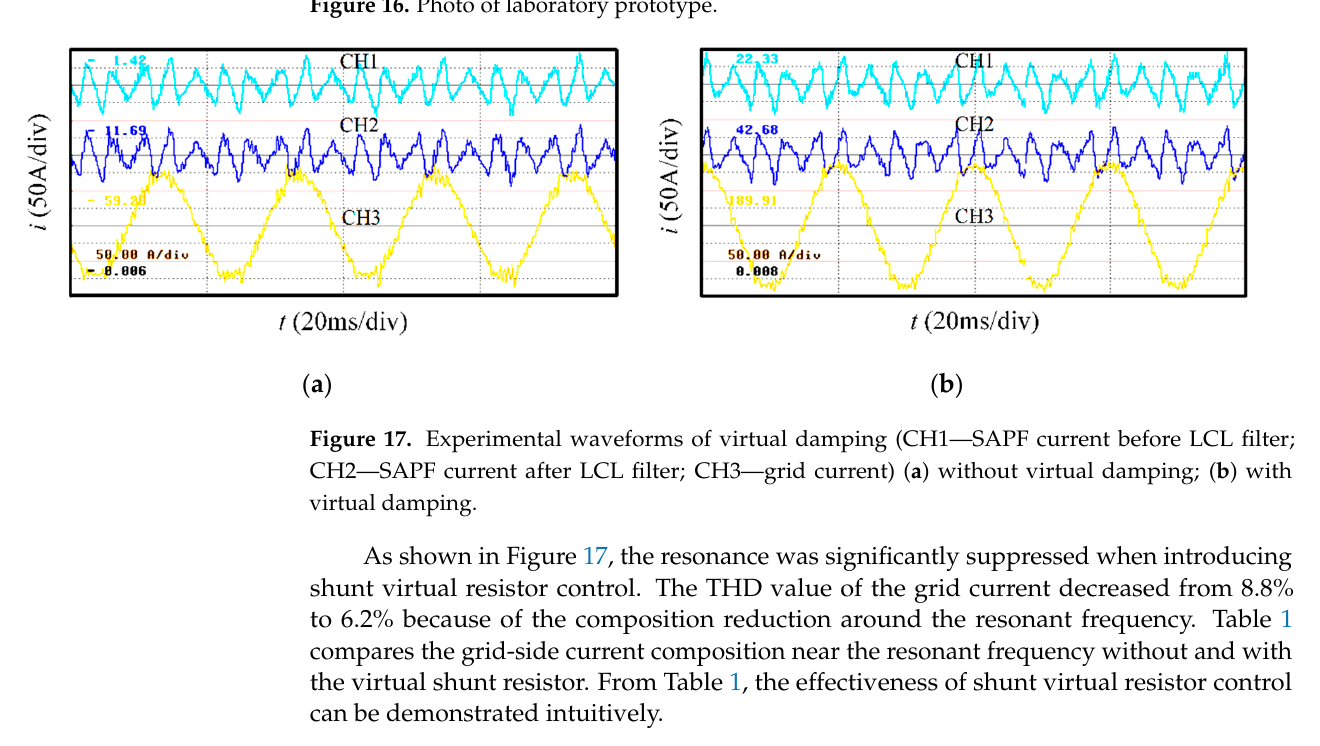
Figure 16. Photo of laboratory prototype.